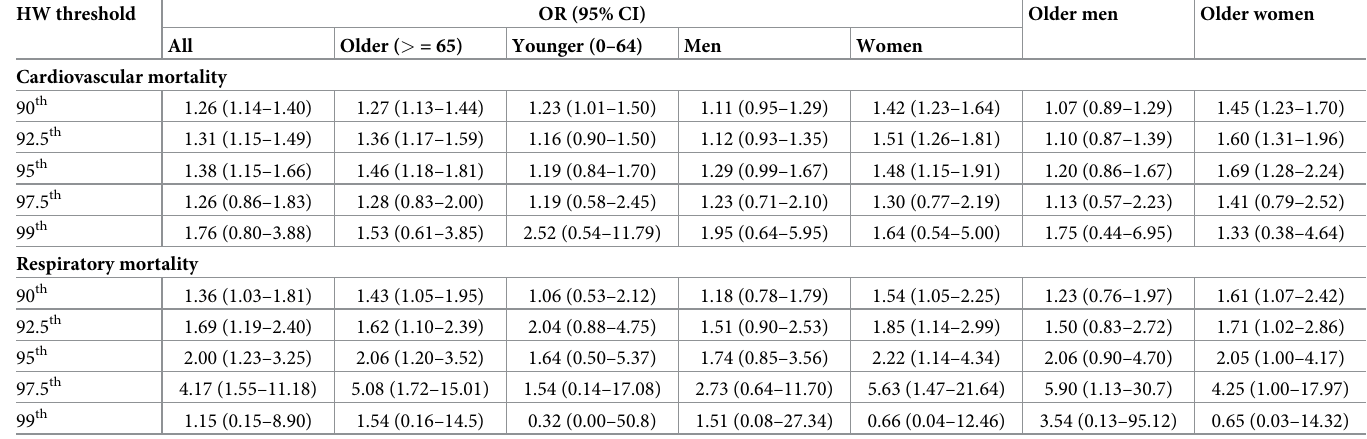
Table 2. Odds ratios (OR) and 95% confidence intervals (95% CI) for the cumulative effect of heat waves on cardiovascular and respiratory mortality, over 5 and 10-day lags respectively, in the city of Rio de Janeiro, Brazil, stratified by age and sex. HW threshold OR (95% CI) Older men Older women All Older ( > = 65) Younger